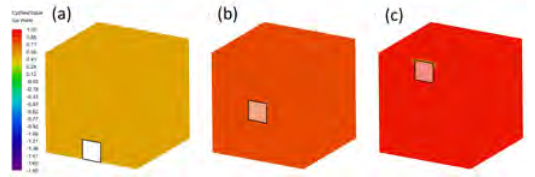
Figure 14. Investigation on a 1m x 1m x 1m cube due to the position of the opening: (a) Opening at the bottom, (b) opening in the middle and (c) opening at the